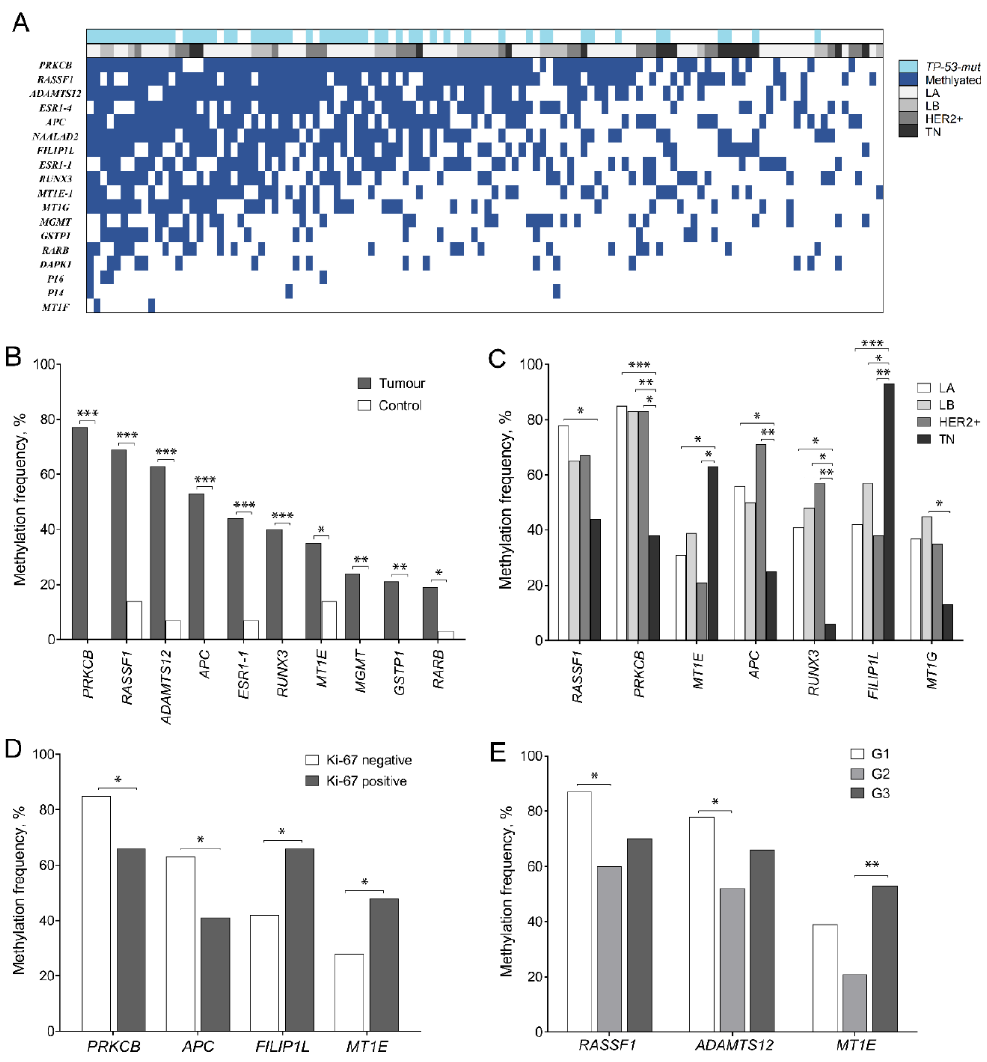
Figure 1. Promoter methylation frequencies of the analyzed genes in breast cancer (BC): heatmap of entire BC cohort ( A ), tumors vs. controls ( B ), BC cases according to the intrinsic subtypes ( C ), tumor Ki-67 status ( D ), and differentiation grade ( E ). G1—good, G2—moderate, G3—poor differentiation grade; HER2+ − HER2 positive and Luminal B HER2 positive; LA—Luminal A; LB—Luminal B; TN—triple-negative BC; TP53-mut — TP53 mutated; * p < 0.05; ** p < 0.01; *** p < 0.001. The comparison of promoter hypermethylation between ductal and lobular BC re- vealed more frequent MT1E methylation in ductal BC (40% vs. 7%; p = 0.018). Tumor stage analysis showed that the P16 promoter was methylated only in stage T2 tumors (8% vs. 0%; p = 0.041), while promoter hypermethylation of RUNX3 was significantly more common in cases with affected nodes (52% vs. 31%; p = 0.032). Analysis of associations between biomarkers and tumor grading revealed statistically significant differences in promoter hypermethylation of RASSF1, ADAMTS12 (G1 vs. G2), and MT1E (G2 vs. G3) ( p < 0.05; Figure 1E). Promoter methylation frequencies of ADAMTS12 (64%), ESR1-4 (53%), MT1E (40%), and DAPK1 (15%) were higher in the younger patients’ group ( p < 0.05). Detailed methylation distribution between subtypes and other clinical–pathological variables is provided in Supplementary Table